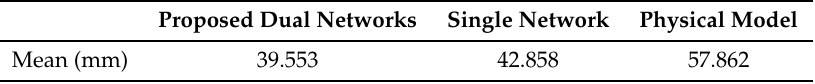
Table 6. Comparison of the prediction error among the proposed dual-network method, single network, and physical